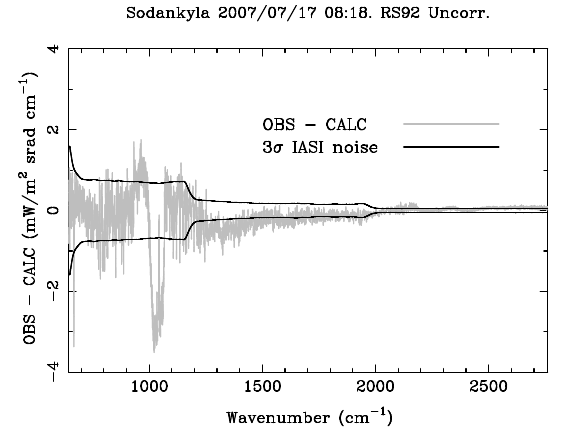
Figure 5. IASI observed minus calculated radiances (OBS-CALC) for the “RS92 Uncorr.” profile.